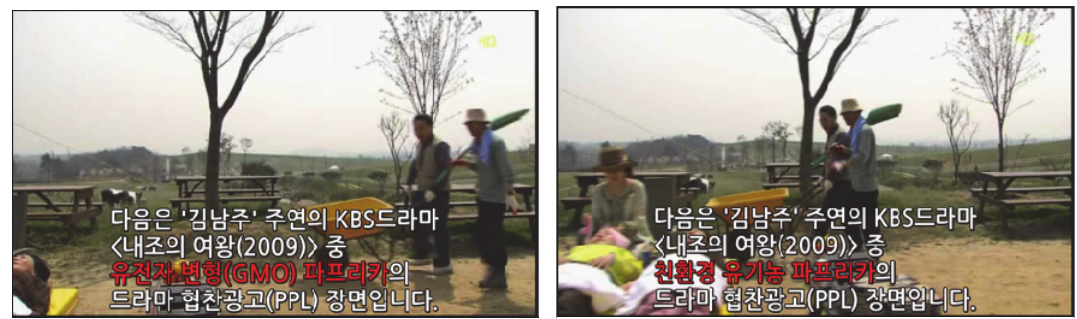
<Figure 9> PPL Scene from Soap Opera for Advertising Genetically Modified Paprika (Left) and Organic Paprika